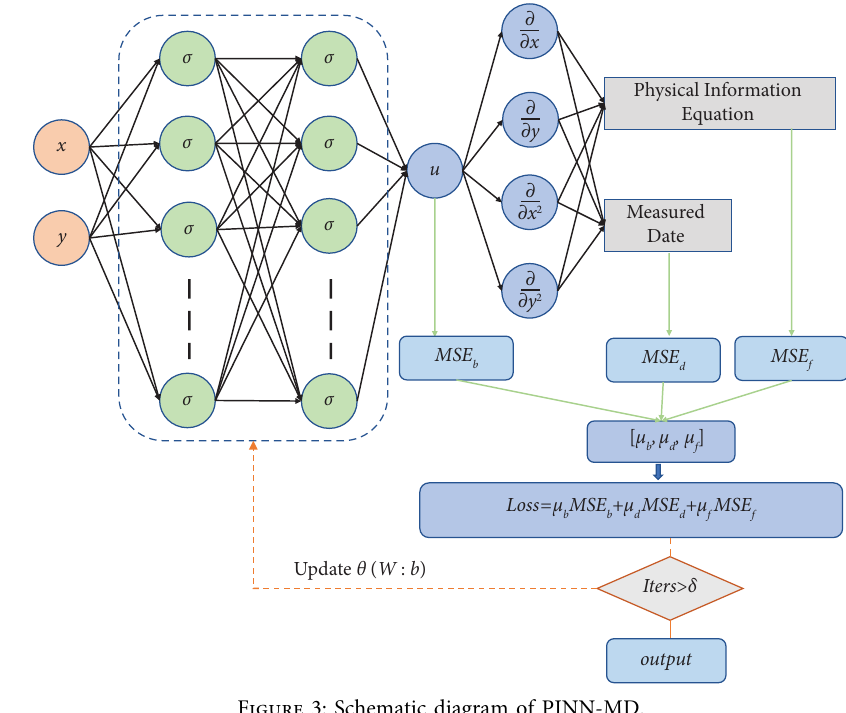
Figure 3: Schematic diagram of PINN-MD.